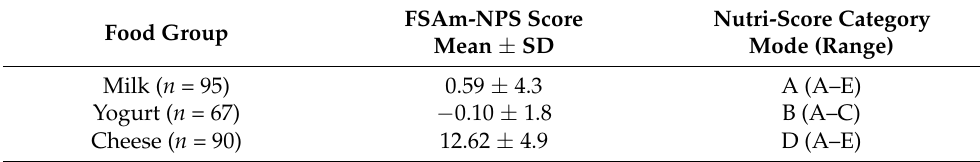
Table 4. FSAm-NPS Score and Nutri-Score category among the dairy subgroups. Food